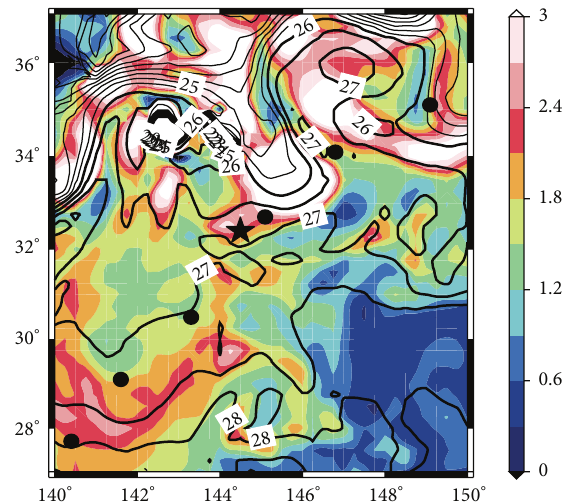
Figure 2: Horizontal distribution of mean sea surface temperature (contours) (average of the 14 initial values in the daily MOVE data) anditsstandarddeviation(colorscale)attheinitialintegrationtime. The contour interval is 0.5 ∘ C, the star shows the location of the KEO moored buoy, and the black circles show the track of Typhoon Choi-